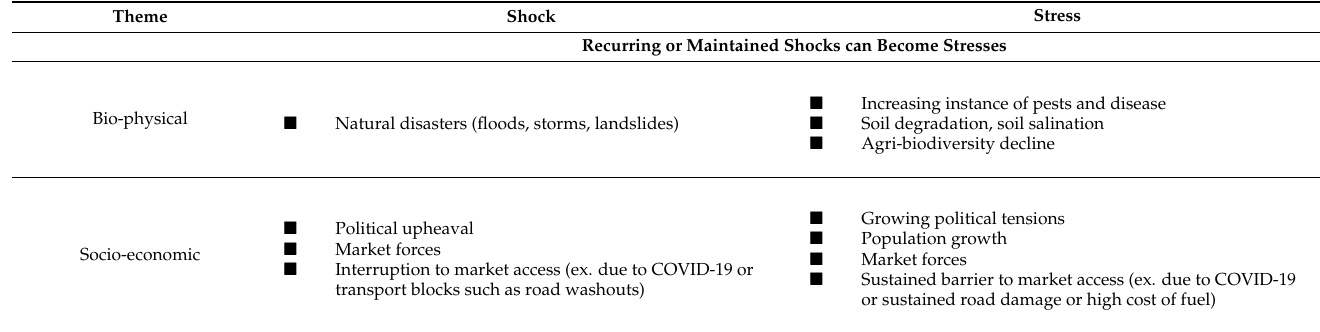
Table 1. Examples of shocks and stresses present in Melanesian food systems